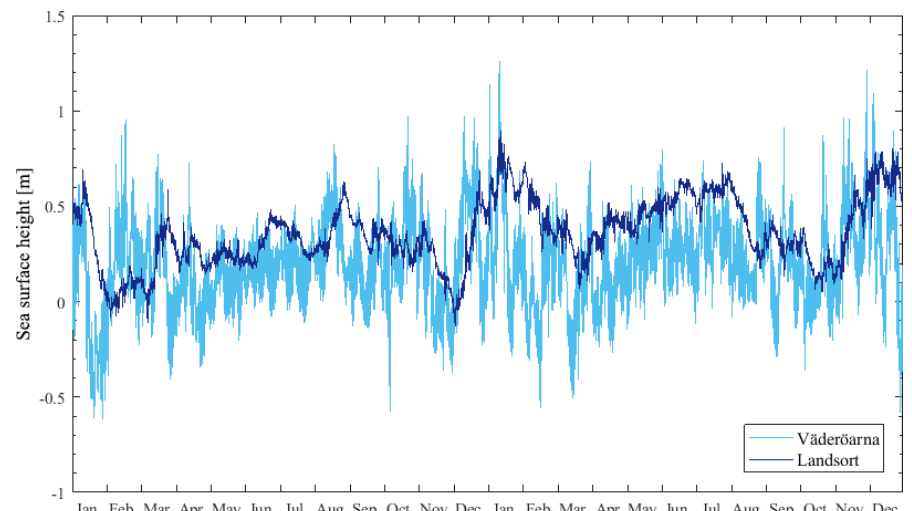
Figure 3. SSH time series from January 2014 to December 2015 at the stations of Väderöarna in the Skagerrak and Landsort in the north- western Gotland